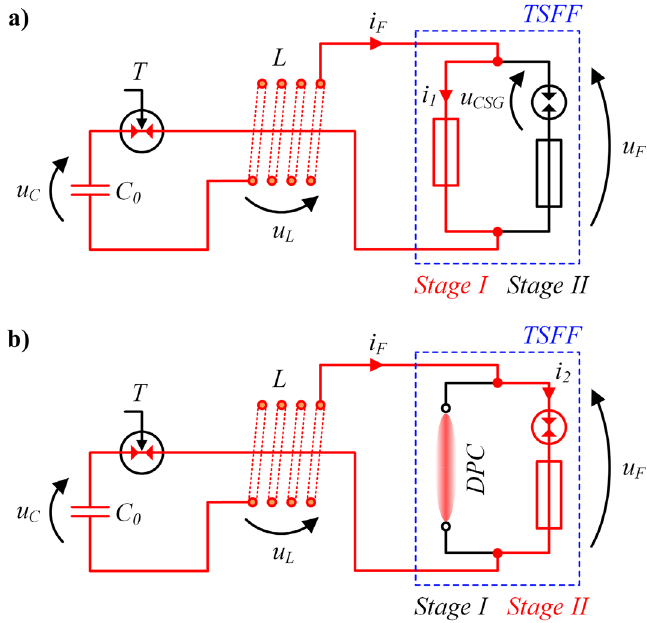
Figure 4. Schematic diagram of the TSFF-based PFS during operation in the preparatory phase ( a ) and in the pulse forming phase after inter-stage commutation ( b ): C 0 —pulse capacitor bank with voltage u c , T —trigatron (triggered spark gap), L —forming inductance, DPC —deionizing plasma channel, i F , u F —fuse current and voltage, i 1 , i 2 —preparatory and forming stage current.